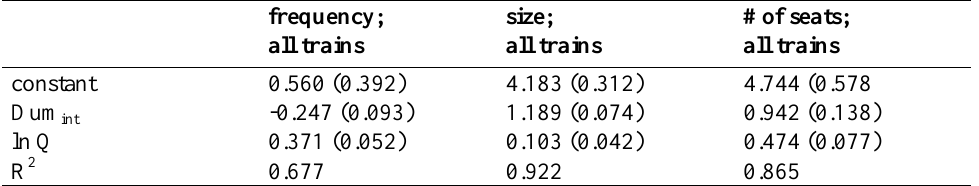
Table 3. Estimation results of dependence of service frequency and vehicle size on passenger demand, making use of instrumental variables (standard errors in brackets). frequency; all trains